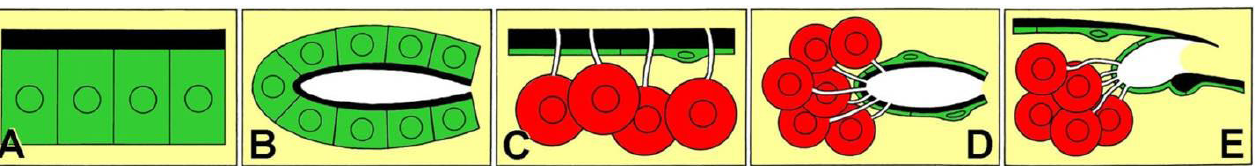
Fig 1 . General gland types, with types A and B formed by epithelial class-1 glandular cells, types C, D and E formed by bicellular secretory units containing class-3 gland cells. Gland types A and C have no reservoir and release their secretion directly to the exterior, types B, D and E have a reservoir for temporary storage of secretion. This reservoir can be formed by an invagination of an intersegmental membrane, see type E (from Billen,